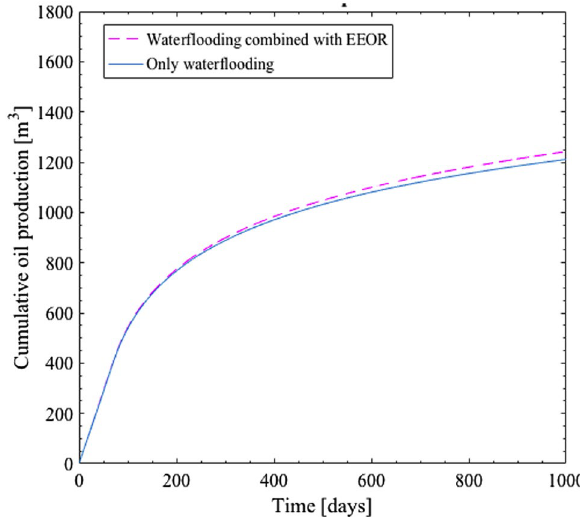
Fig. 11 Comparison of cumulative oil production for two cases: (1) only water flooding, and (2) combination of EEOR and water flood-